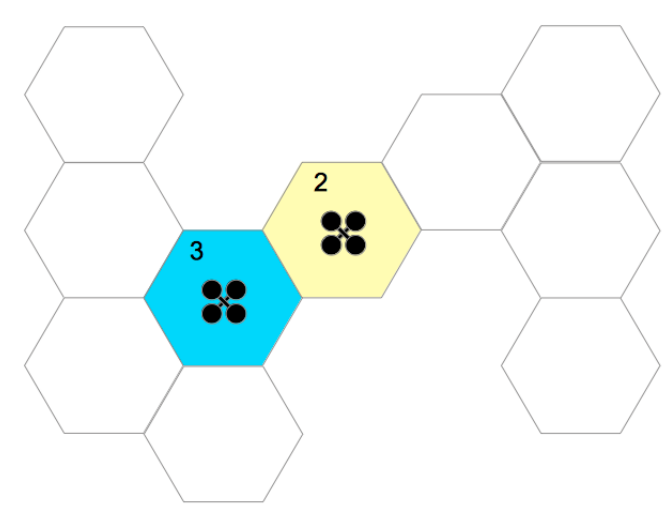
Figure 7. Adjacent Degree: blue hexagon has AD = 3, while yellow hexagon AD =